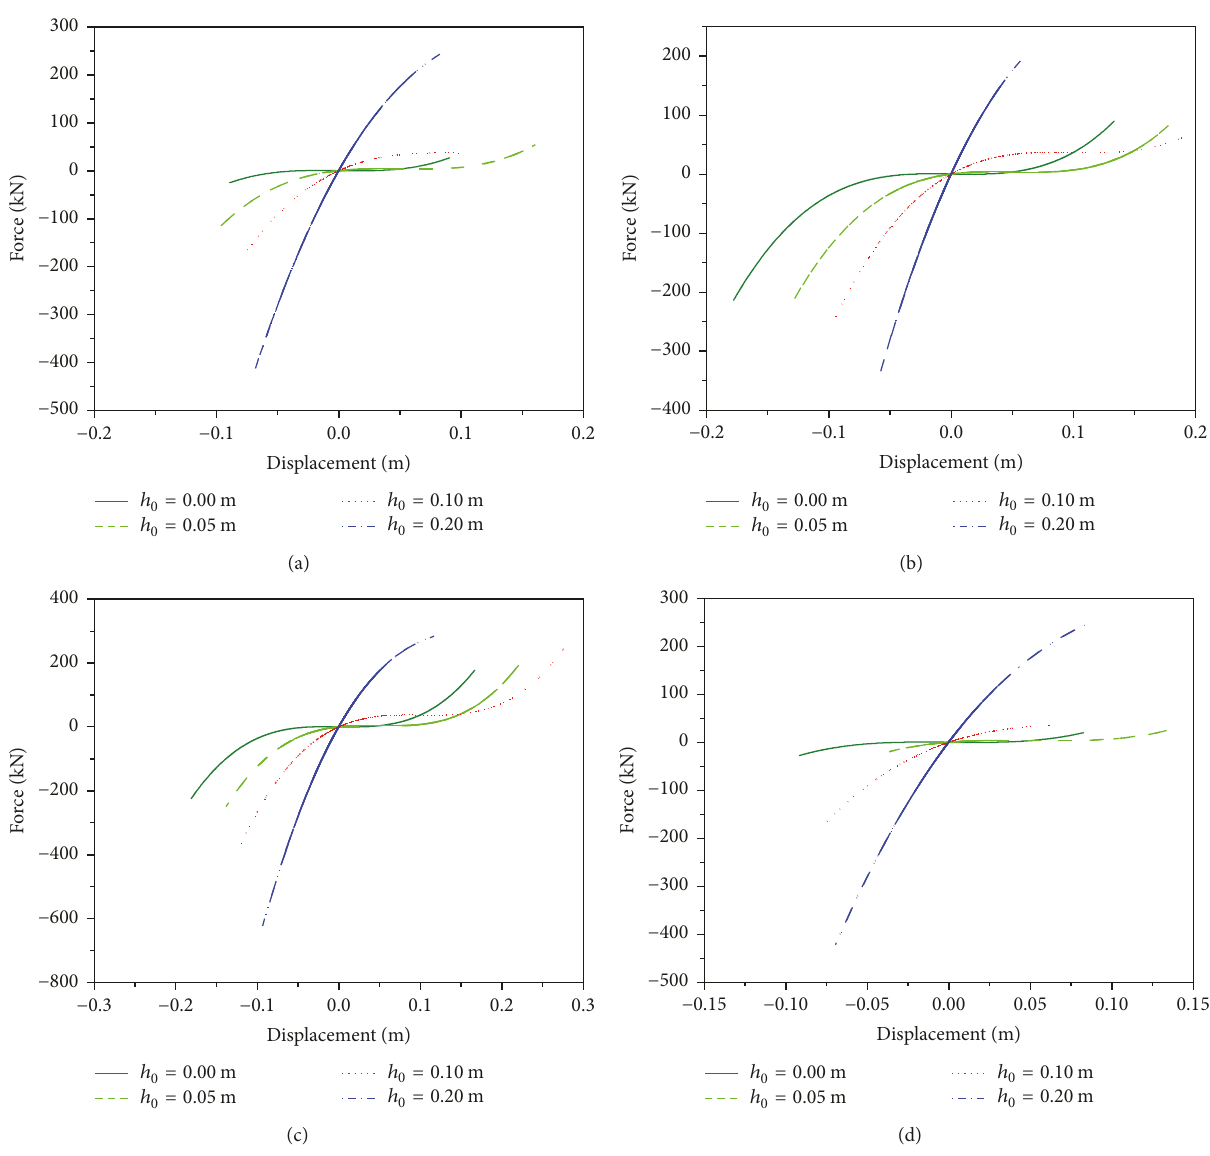
Figure 7: Comparison of elastic displacement versus force response curves for a seismic isolated structure with QZS: (a) Loma Prieta- Saratoga-Aloha Ave.; (b) Kocaeli-Izmit; (c) Chi-Chi-TCU089; (d)